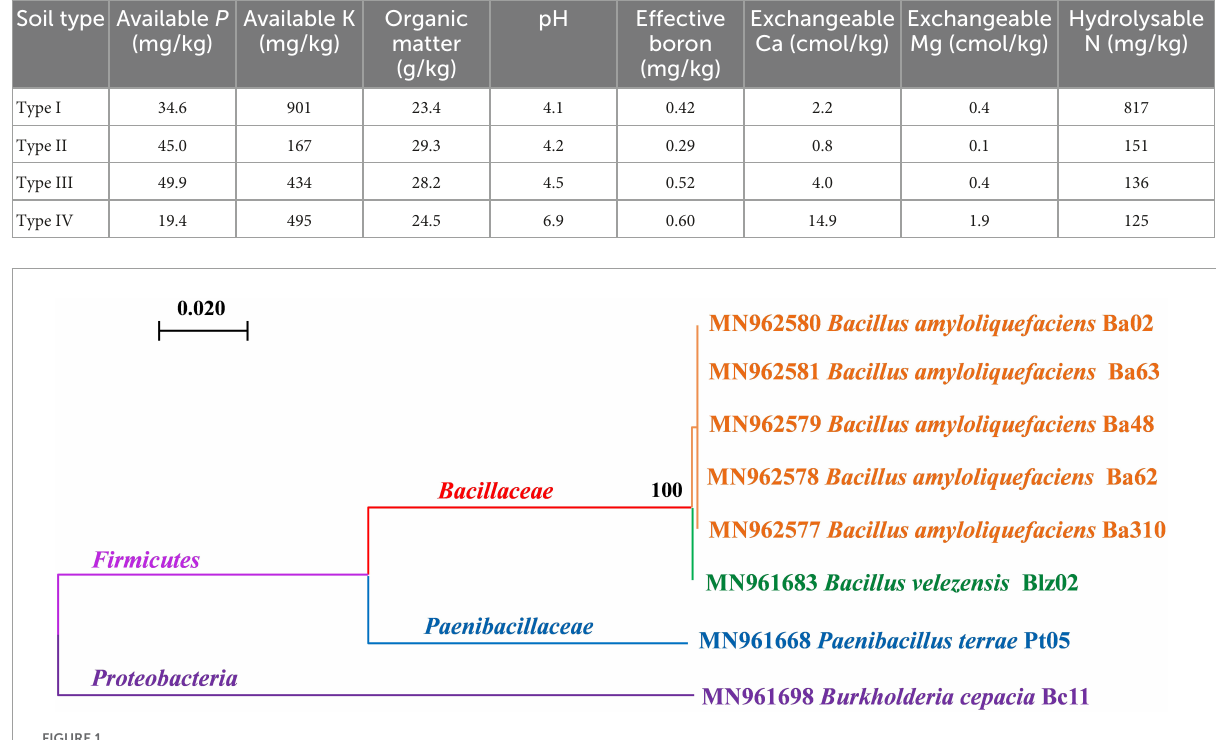
TABLE 2 Physicochemical properties of soil samples from different banana plantations.